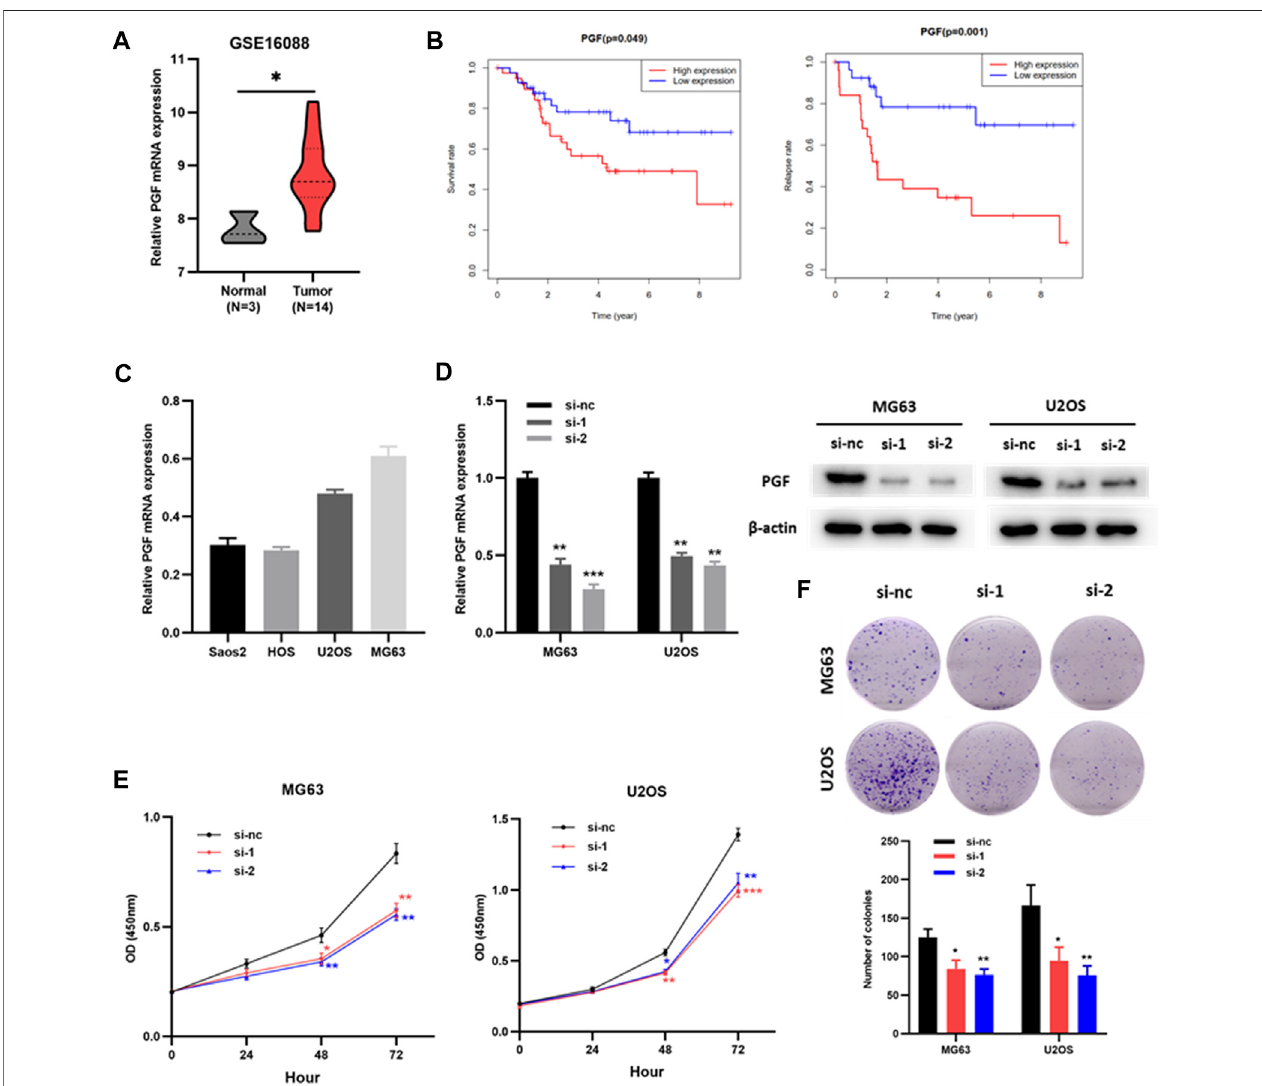
FIGURE8| KnockdownofPGFinhibitedtheproliferationandviabilityofosteosarcomacells. (A) PGFexpressioninnormalbonetissuesandosteosarcomatissues (GSE16088). (B) The OS and RFS analysis of PGF expression in validation cohort (TARGET). (C) PGF mRNA expression in osteosarcoma cells. (D) PGF knockdown MG63andU2OScellswereconstructedandcon fi rmedbyRT-PCRandWesternblotting. (E) TheproliferationabilityofMG63andU2OScellswithPGF(si-nc,si-1orsi- 2) via CCK8 assays. (F) Plate clone formation assays of MG63 and U2OS cells with PGF (si-nc, si-1 or si-2). * p < 0.05, ** p < 0.01, *** p < 0.001.